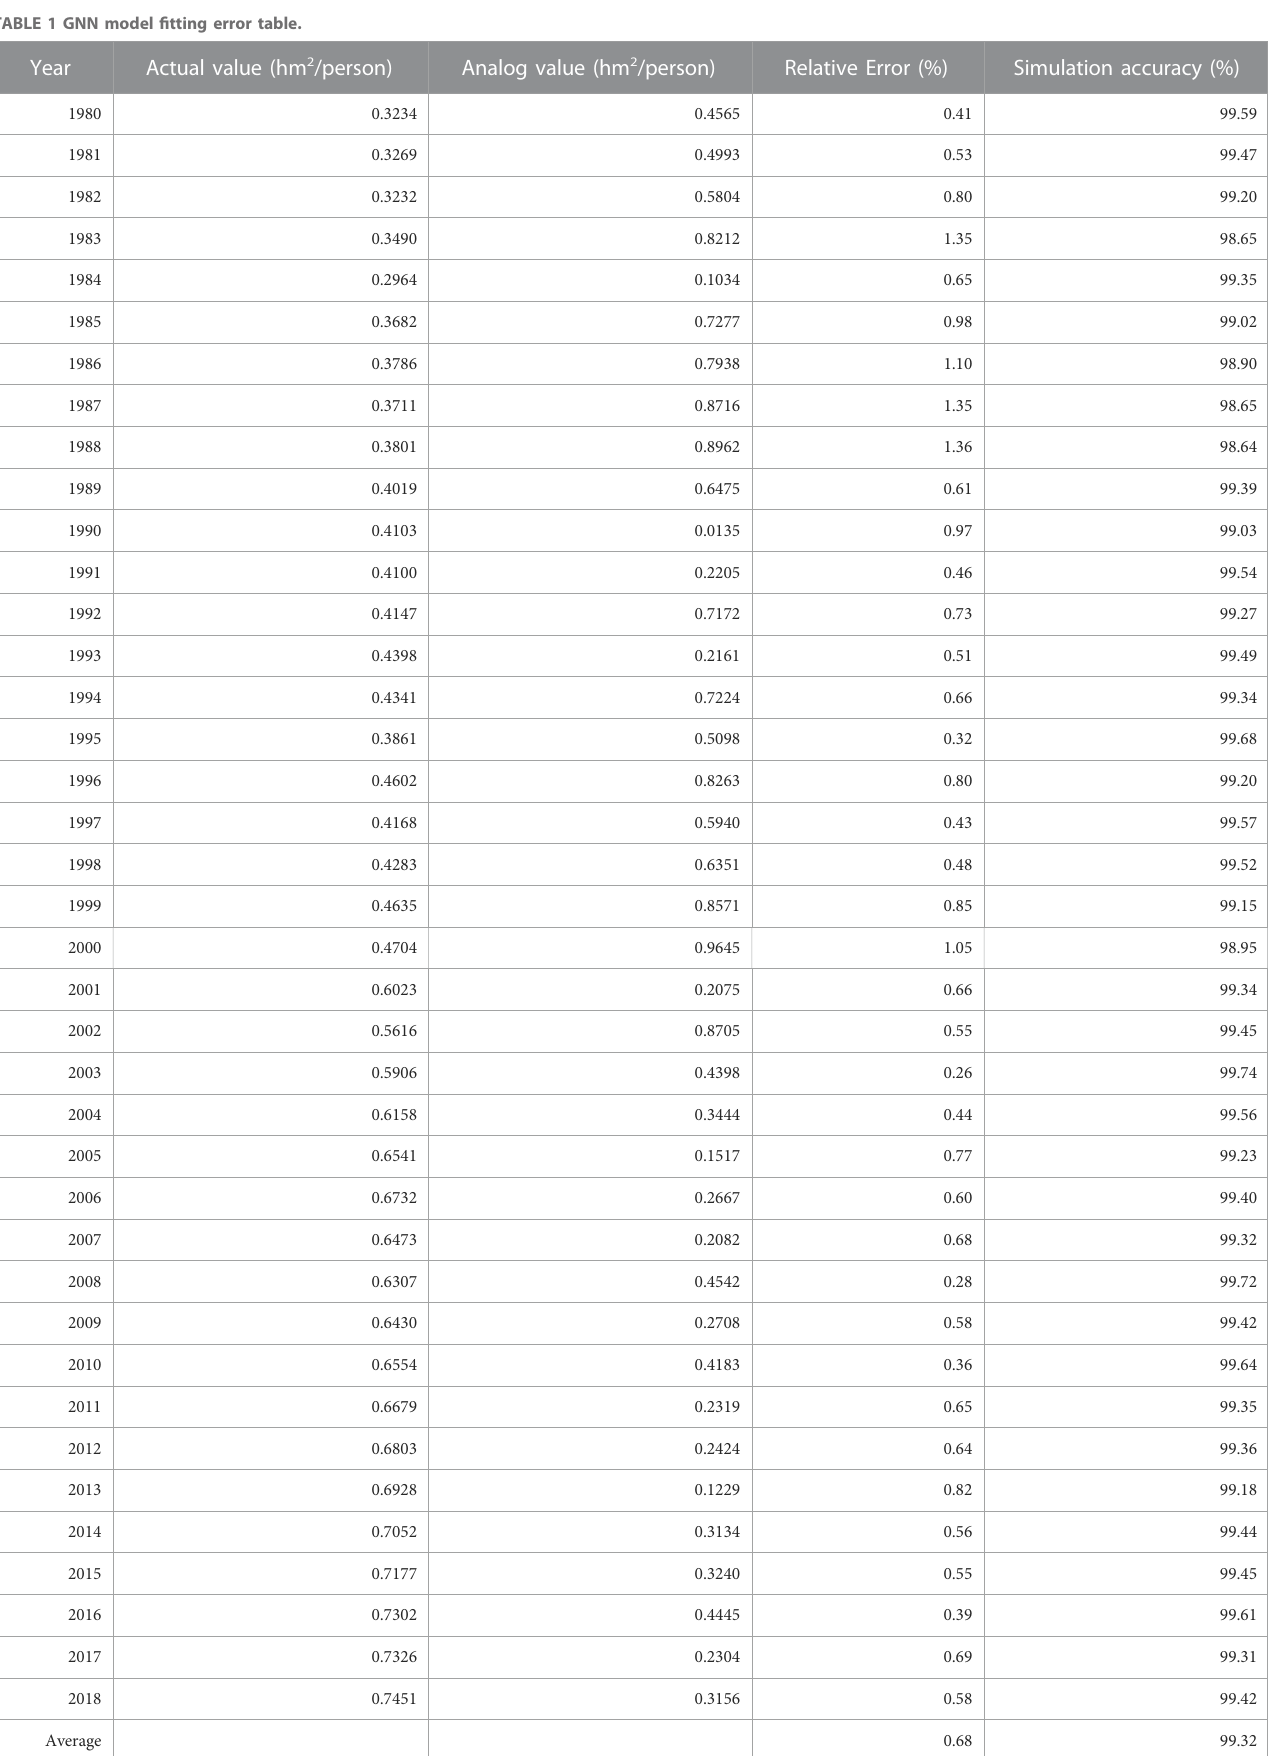
TABLE 1 GNN model fi tting error